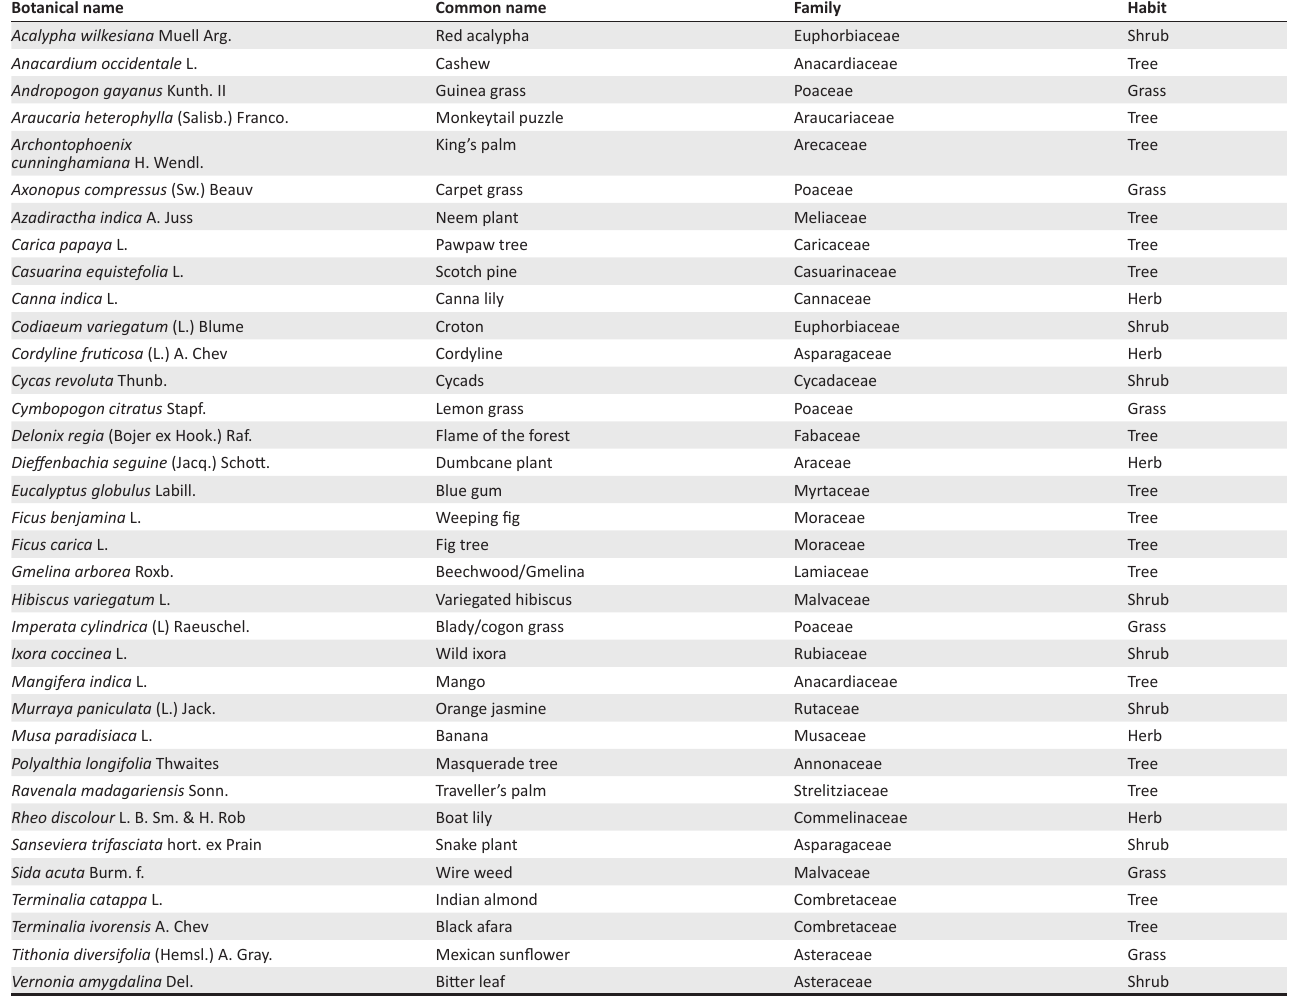
TABLE 2: Distribution of plant species in Lagos State University campus. Botanical